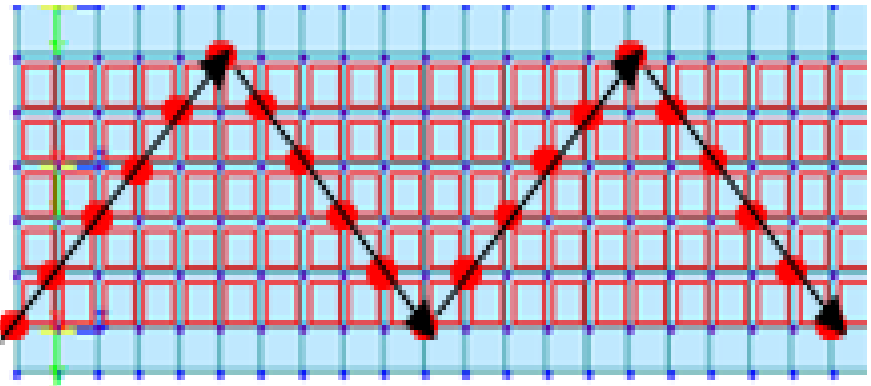
Figure 11. Example of movement of vehicle load for RC-slab-bridge modeling.